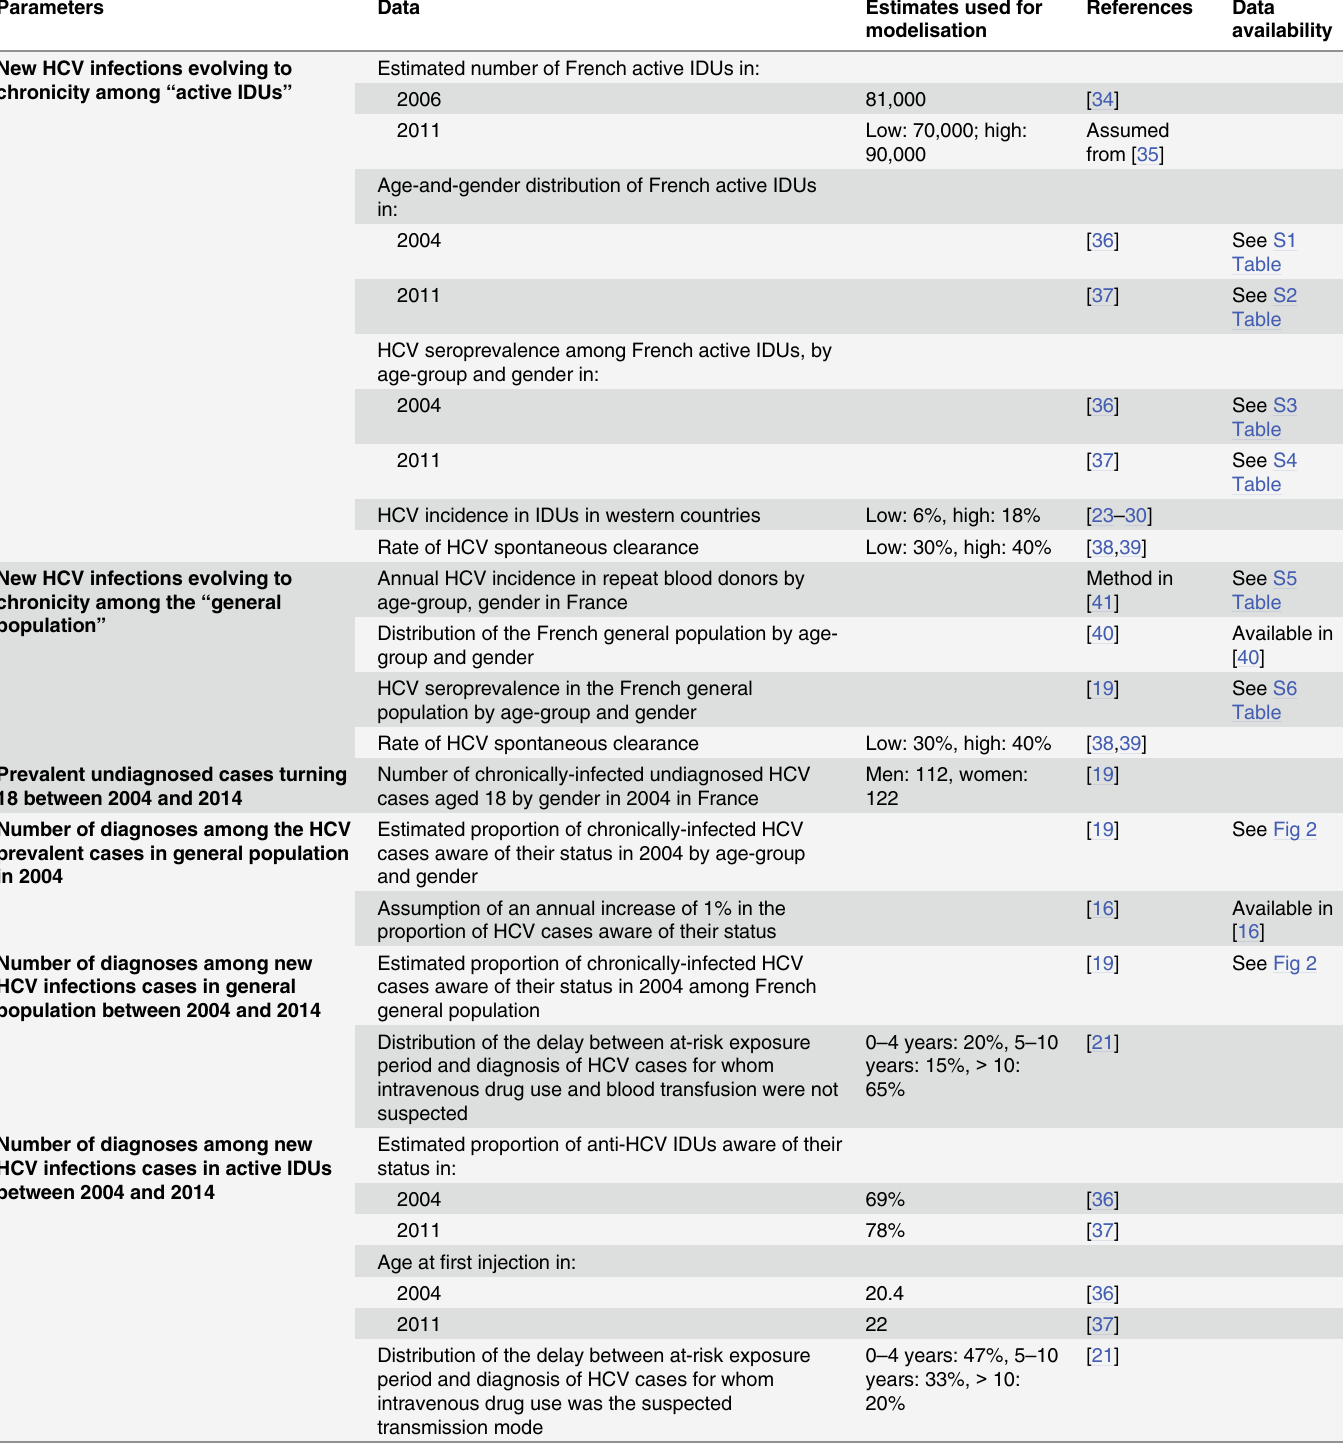
Table 1. Parameter values and data used for 2014 model-based